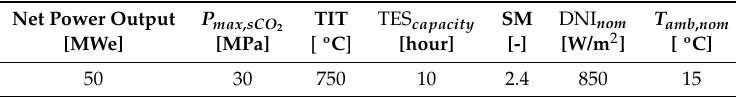
Table 2. Specifications of the reference sCO 2 power plant.